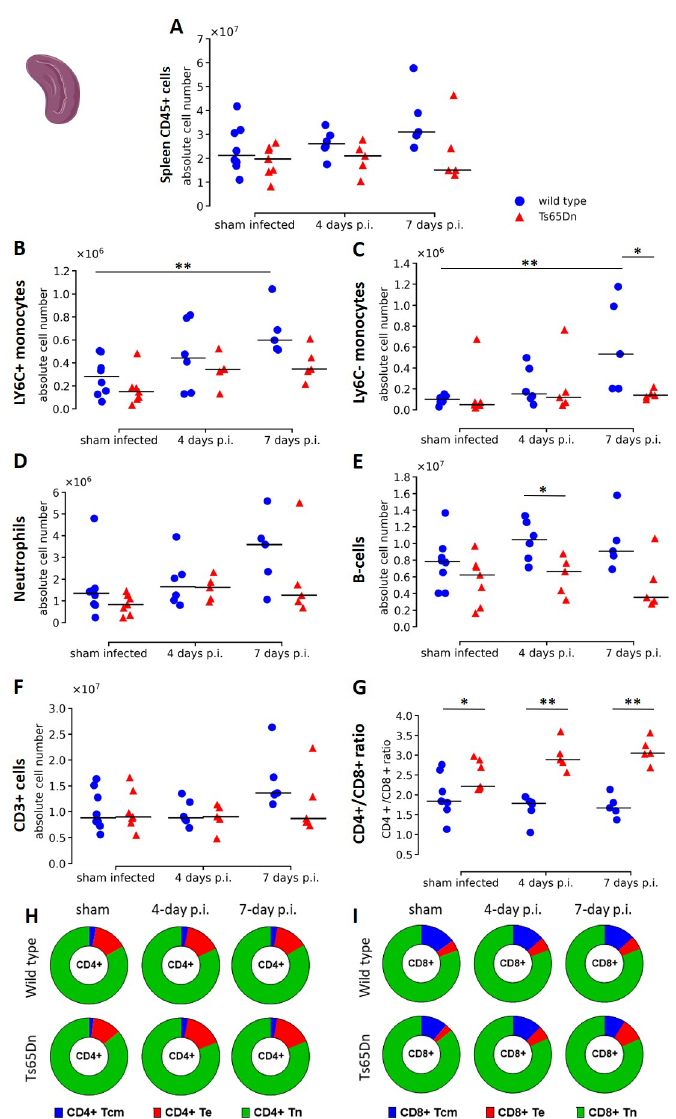
Figure 7. Immunological status of the spleen in wild type and Ts65Dn mice throughout rhRSV-Luc infection. ( A ) The absolute number of Leukocytes (CD45+). ( B ) Neutrophils (CD45+ Lin − CD11b+ Ly6G+), ( C ) B cells (CD45+ CD3 − NK1.1 − B220+). ( D ) Ly6C+ monocytes (CD45+ SiglecF- CD103- Ly6G- CD11bhi MHCII- Ly6C+). ( E ) Ly6C − monocytes (CD45+ SiglecF- CD103- Ly6G- CD11bhi MHCII- Ly6C-) were presented. ( F ) The absolute number of splenic CD3+ lymphocytes. ( G ) The ratio of CD4+ over CD8+ cells T cells were presented as individual values with group median. The proportions of, respectively. ( H ) CD4+. ( I ) CD8+ Tcm (CD44+ CD62L+; blue), Te (CD44+ CD62L − ; red), and Tn (CD44 − CD62L+; green) of the total T cell population are shown and presented as proportion of total CD4+ and CD8+ T cells. * p < 0.05, ** p <